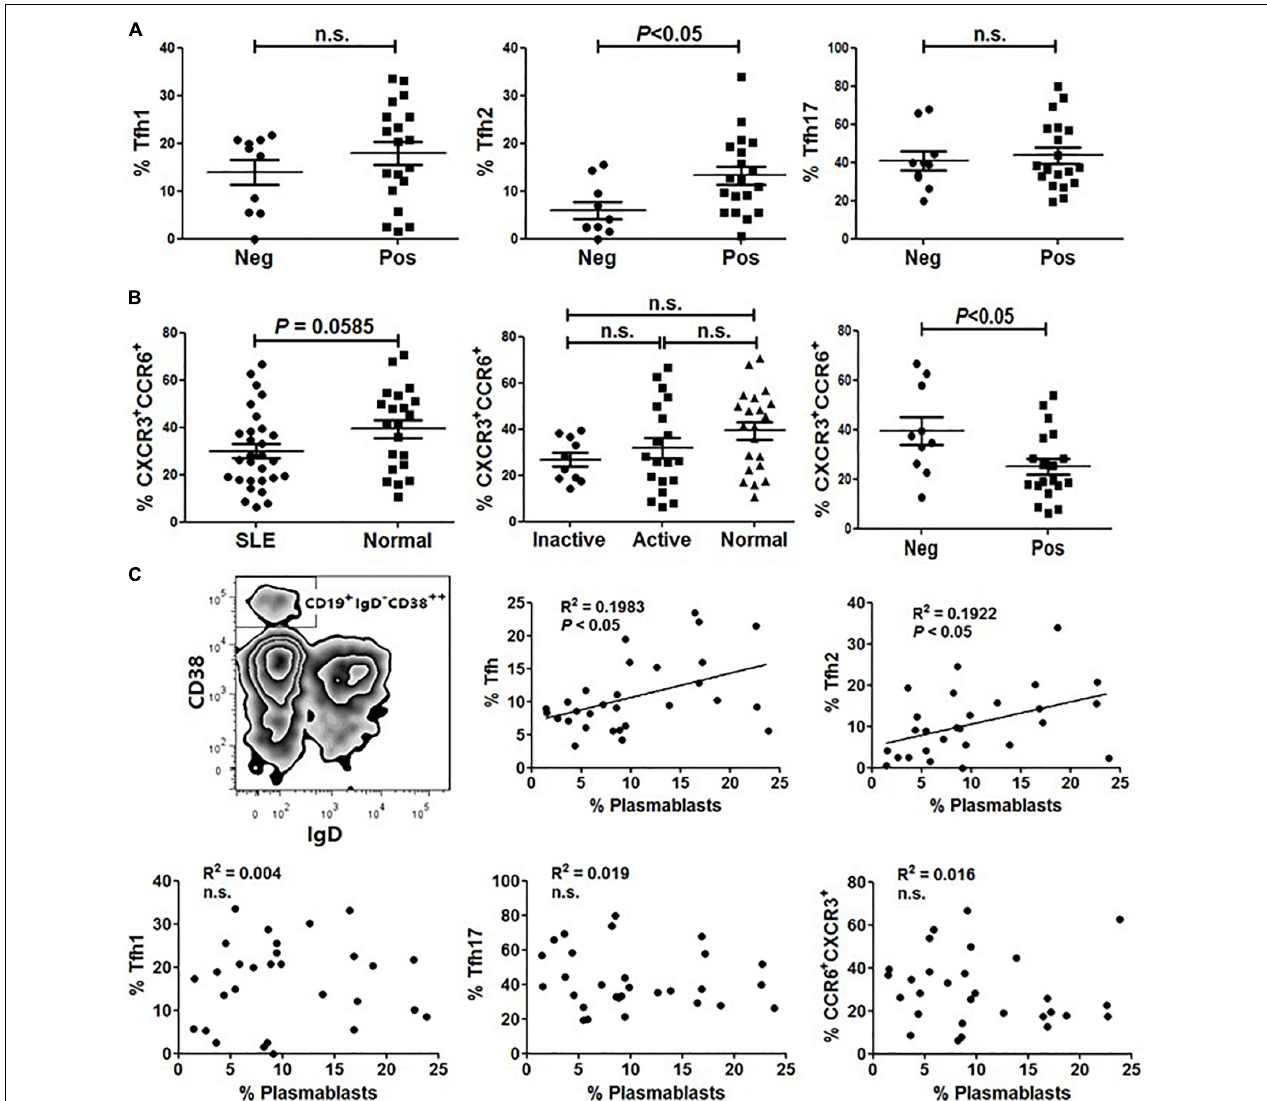
FIGURE 3 | The frequency of Tfh2 cells is significantly higher in ANA positive SLE patients and positively correlated with plasmablasts. (A) Frequencies of Tfh1, Tfh2 and Tfh17 cells were analyzed and compared between anti-dsDNA negative SLE patients and anti-dsDNA positive SLE patients. (B) The frequency of CXCR3 + CCR6 + subset on gated CD4 + CD45RA - T cells was analyzed and compared between SLE patients (including inactive and active SLE patients, anti-dsDNA negative SLE patients and anti-dsDNA positive SLE patients) and healthy controls. (C) Plasmablasts were gated as CD19 + IgD - CD38 ++ population, and the correlations between the amount of plasmablasts and frequencies of each type of Tfh cells and Tfh subsets from SLE patients were analyzed. All results are presented as mean ± standard error of the mean (SEM). n.s., not significant.